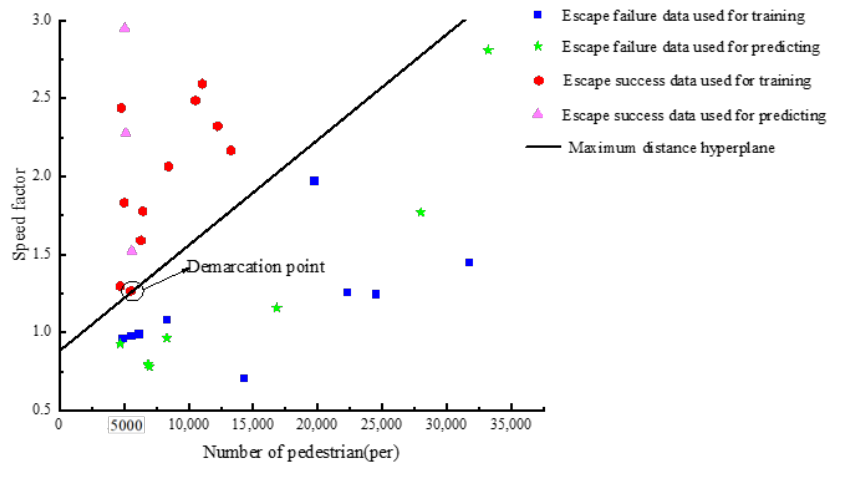
Table 8. Comparison of test classification results and SVM classification results.